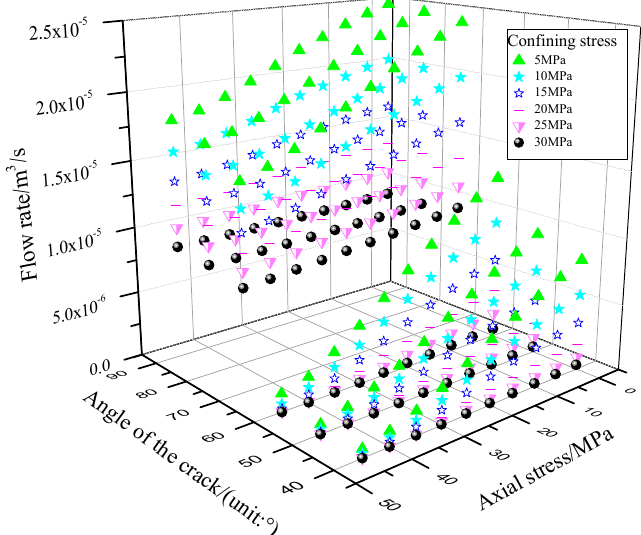
Figure 14. Seepage results with different crack angles.